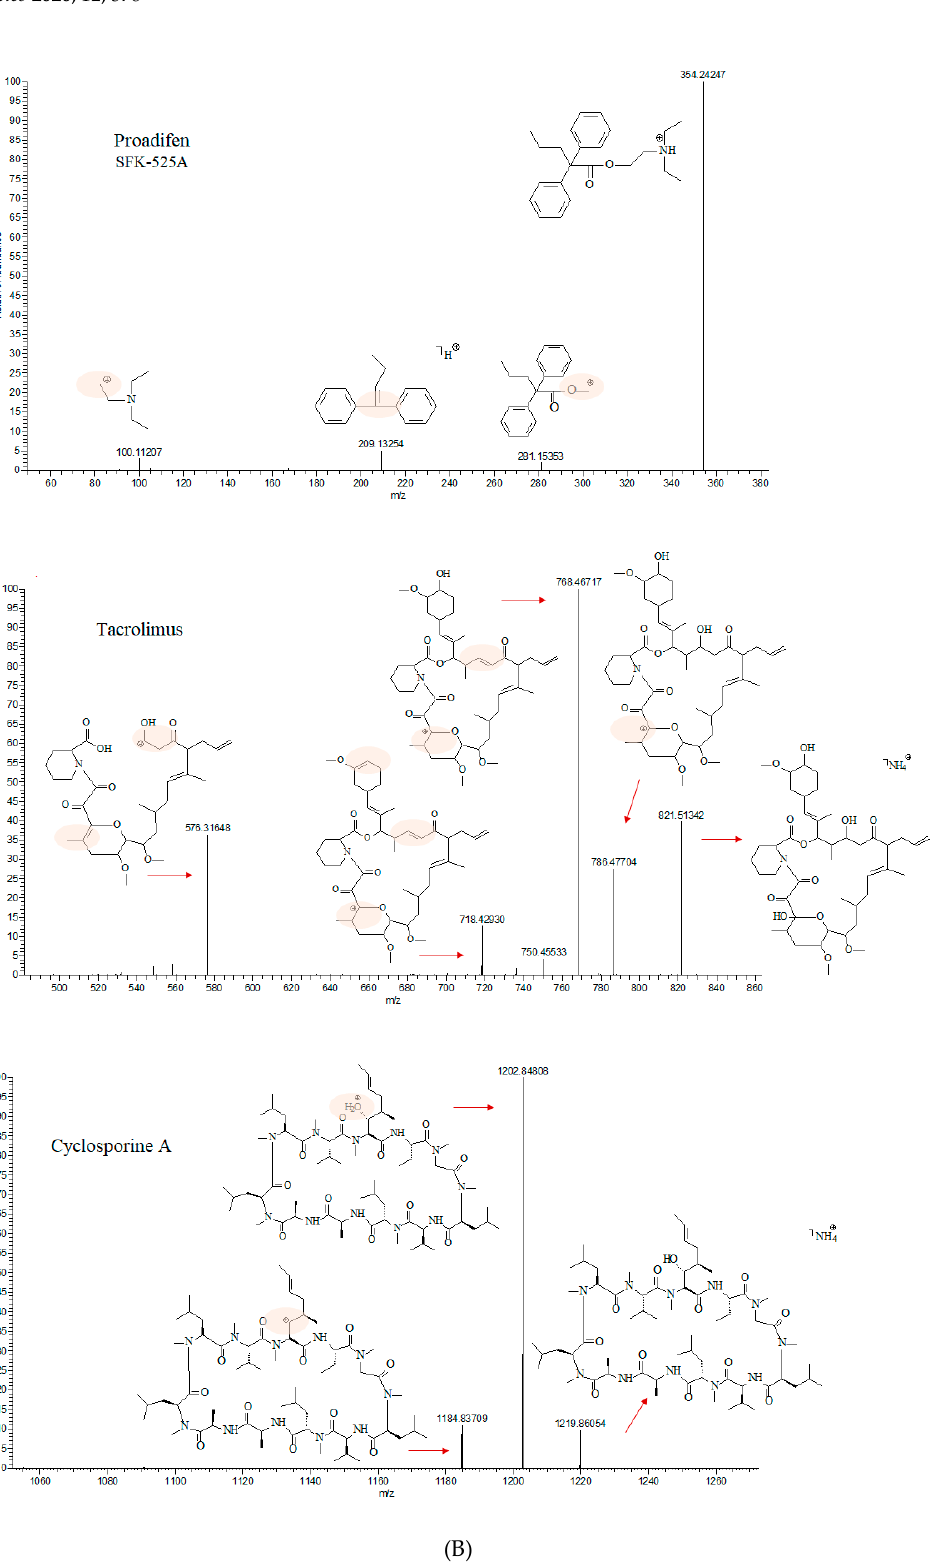
Figure 1. ( A ) Ion chromatograms extracted from full scan (FS), chromatograms of main fragment obtained by mass spectra MS 2 acquisition and mass spectra of proadifen (SKF-525A), tacrolimus and cyclosporine A (100 ng / mL). ( B ) q-Exactive Orbitrap high-resolution mass spectrum and proposed fragmentation pathway of SKF-525A, tacrolimus and cyclosporine A, acquired in Data Independent Acquisition (DIA) mode with a two-step normalized collision energy (10 and 15